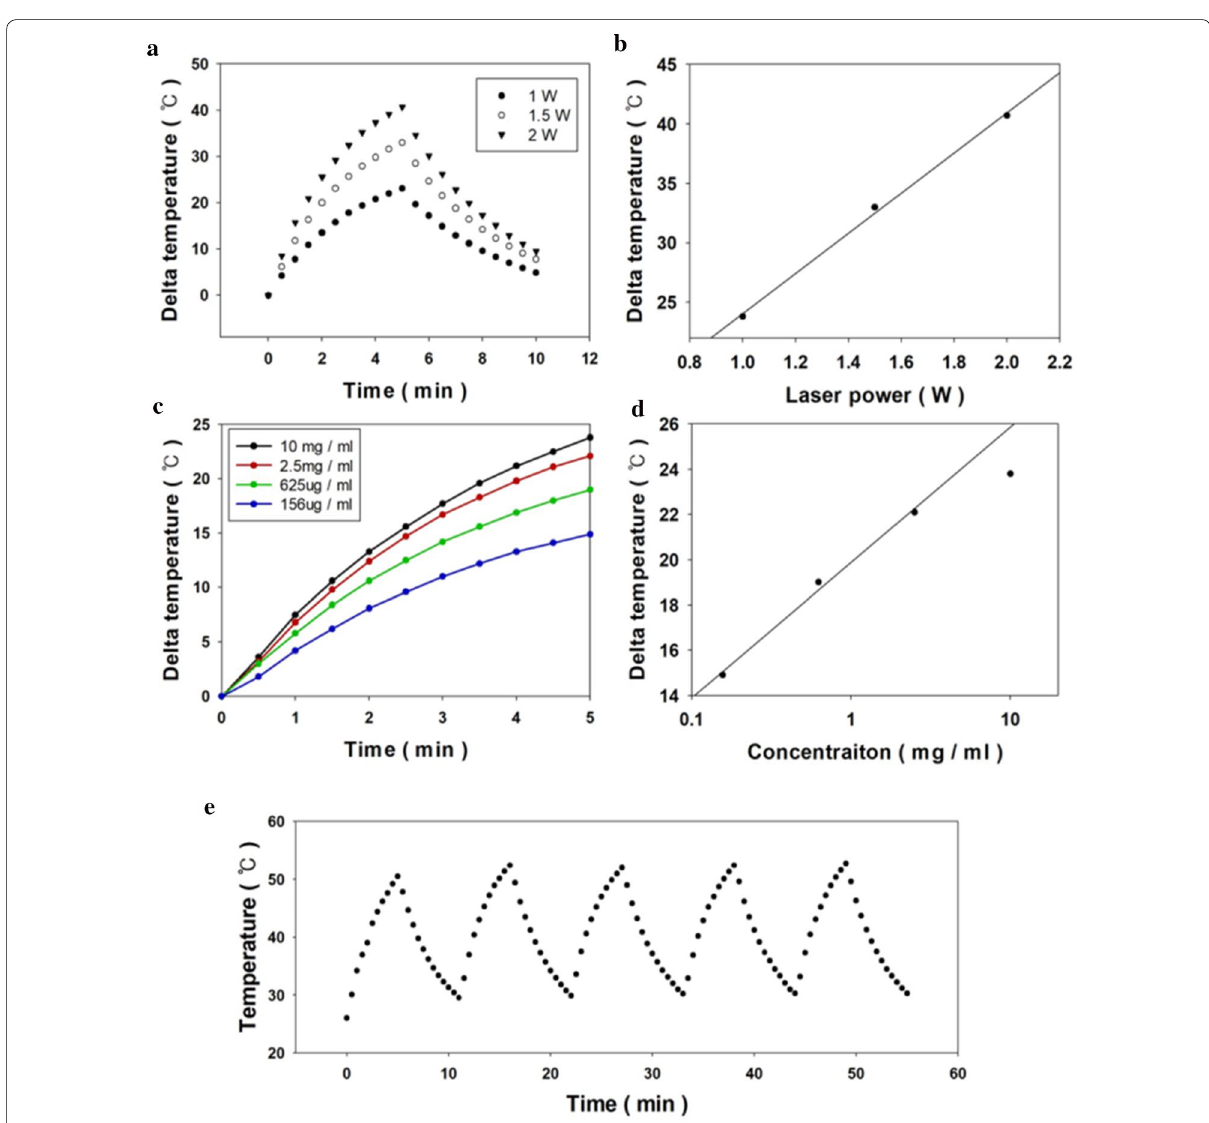
Fig. 5 Photothermal characteristics of the synthesized nanoparticles ( a , b ) according to the laser power, ( c , d ) concentration and ( e ) cycle test (10